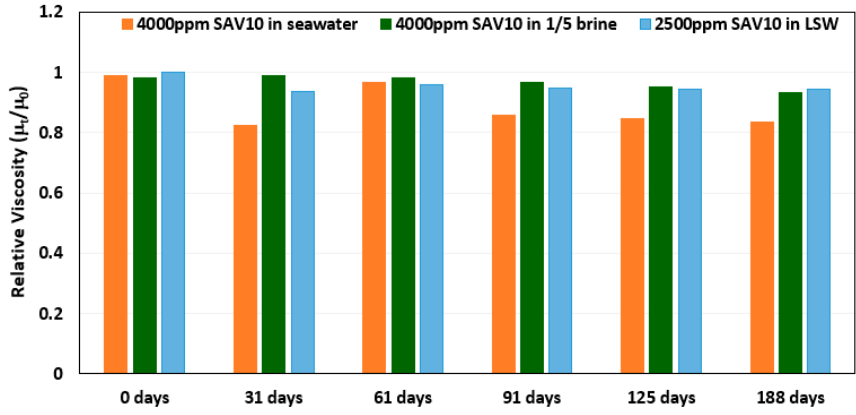
Figure 12. Better thermal stability of Superpusher Terpolymer of Acrylamide, Acrylamido-Tert-Butyl-Sulfonate and N-Vinyl-Pyrrolidone (SAV10) in LSW at 113 °C. LSW = 2935 ppm of TDS; 1/5 brine = 47,869 ppm of TDS; seawater = 49,878 ppm of TDS [15].